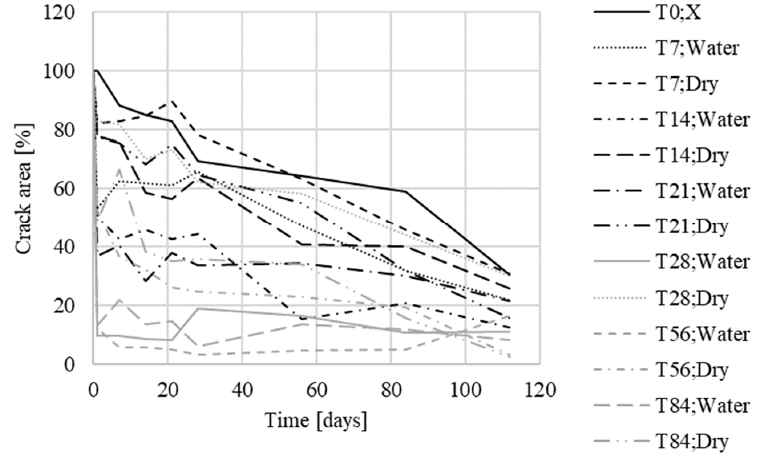
Figure 13. Crack development in specimens with Xypex Admix additive—the second phase (T = time of exposure).